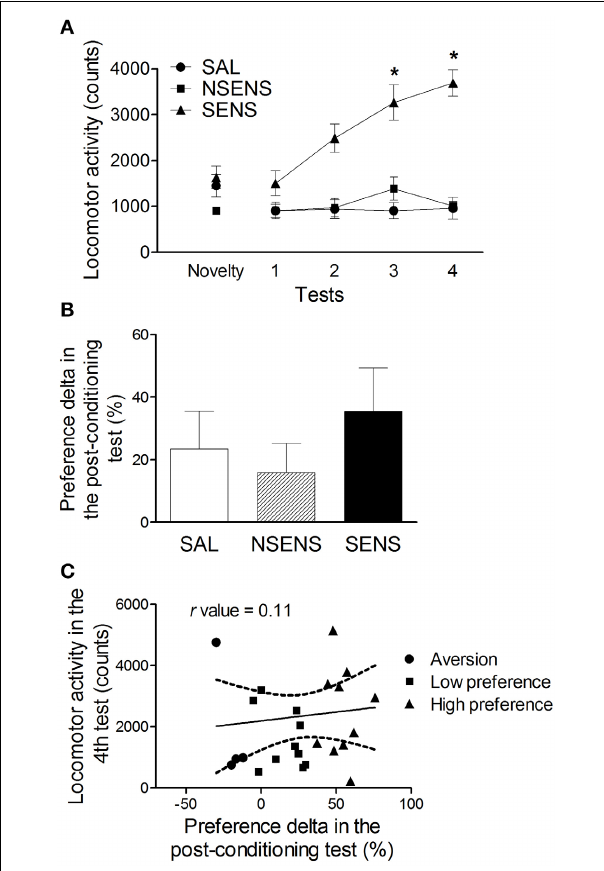
FIGURE 4 | (A) Locomotor activity (mean ± s.e.m) for 15min of mice treated with saline (SAL) ( n = 21) or 2.2g/kg ethanol (NSENS = 19; SENS = 22) in the novelty-exposure test and in tests 1–4 (Experiment 3B). Based on their activity in test 4, the ethanol-treated mice were classified as “sensitized” or “non-sensitized.” *Higher than SAL and NSENS groups on the same test ( P < 0 . 05) and higher than their own levels in test 1 ( P < 0 . 05). (B) Preference delta for the CS + compartment (mean ± s.e.m) in the post-conditioning test of ethanol-conditioned mice (Experiment 3B) classified as SAL ( n = 9), NSENS ( n = 16) and SENS ( n = 17) in the behavioral sensitization protocol. (C) Pearson’s correlation ( r = − 0 . 36, P < 0 . 05) between the preference delta in the post-conditioning test and the locomotor activity in test 4 of ethanol-treated mice. Each point represents a single animal classified according to its preference for the CS + compartment, determined by the classification model described in the text (See Table 1